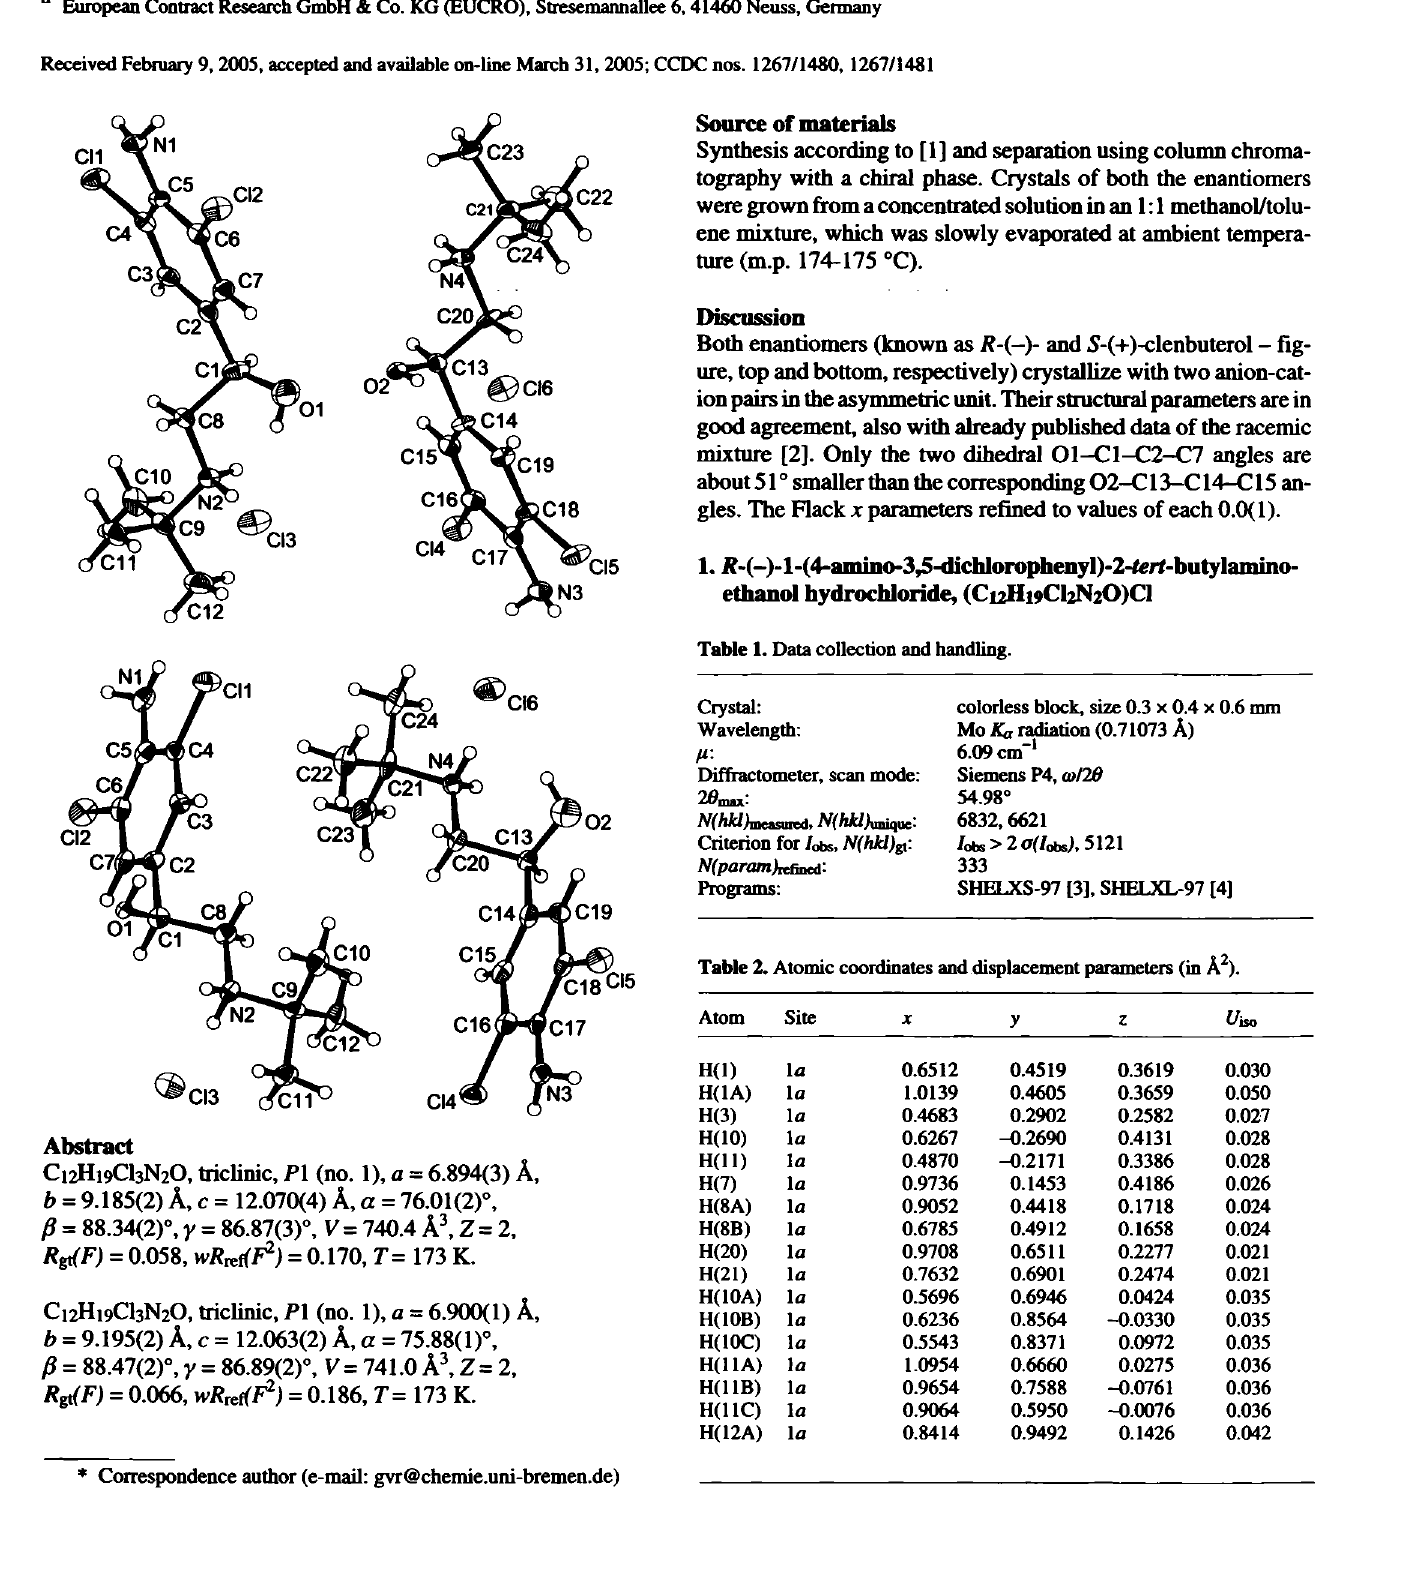
Table 1. Data collection and handling.